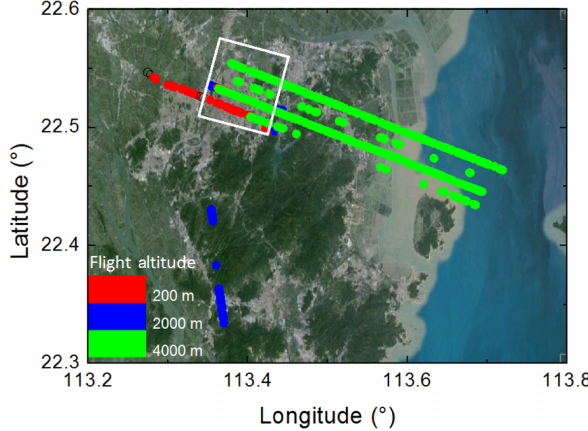
Figure 1. Flight pattern for the airborne measurements in Zhong- shan on 3 December 2009. The area marked with the rectangle shows the position of the measurements which are averaged for the spatially averaged surface albedo and surface reflectance spectra.